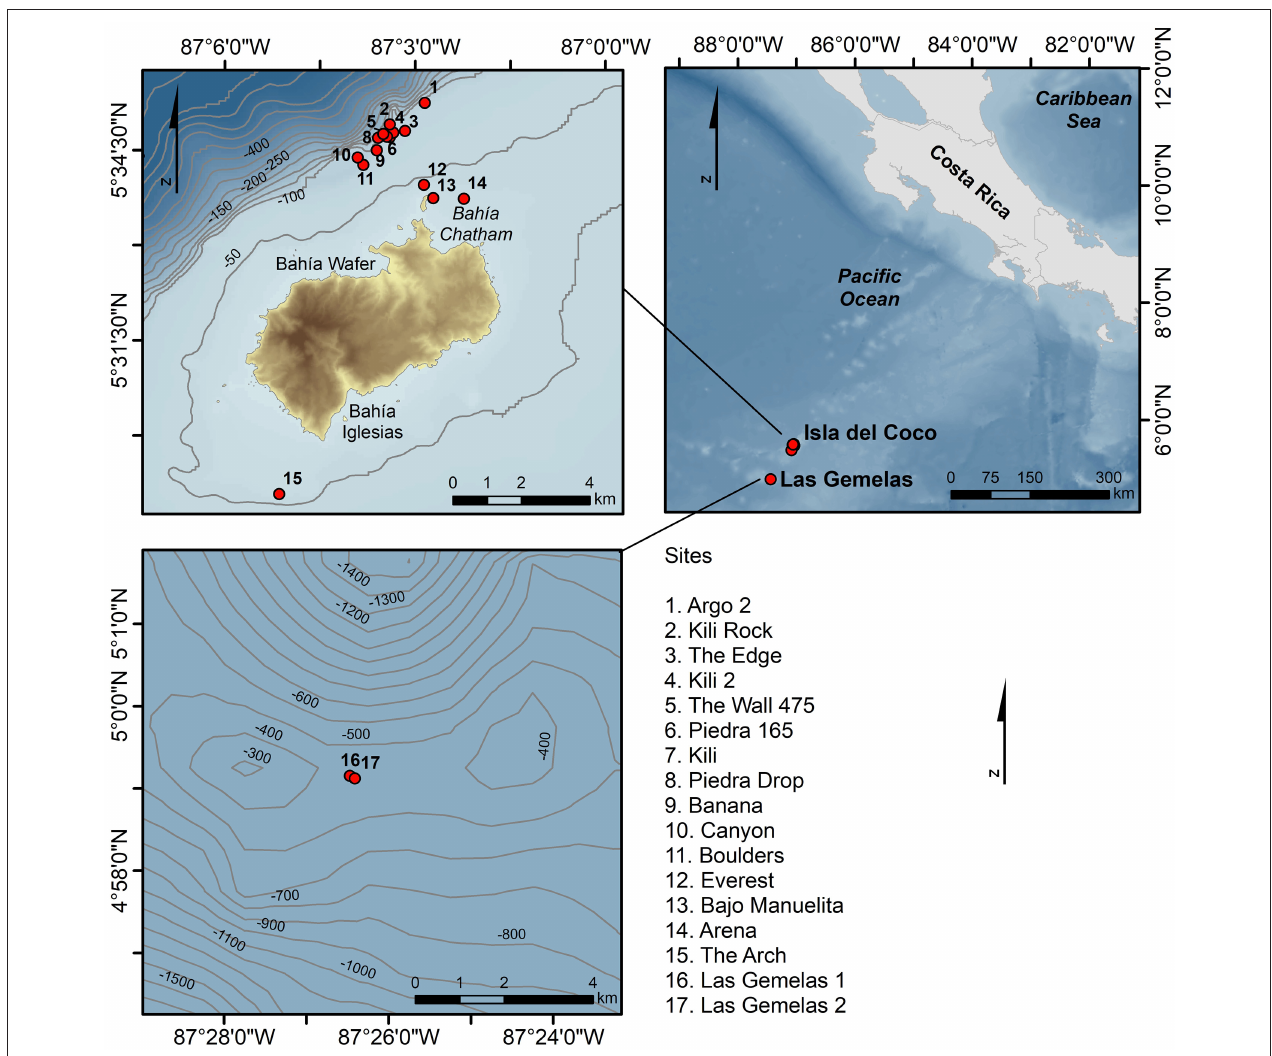
FIGURE 1 | Dive sites (50–450m depth) at Isla del Coco National Park where the submersible DeepSee has acquired images of marine debris (found between 200 and 350m